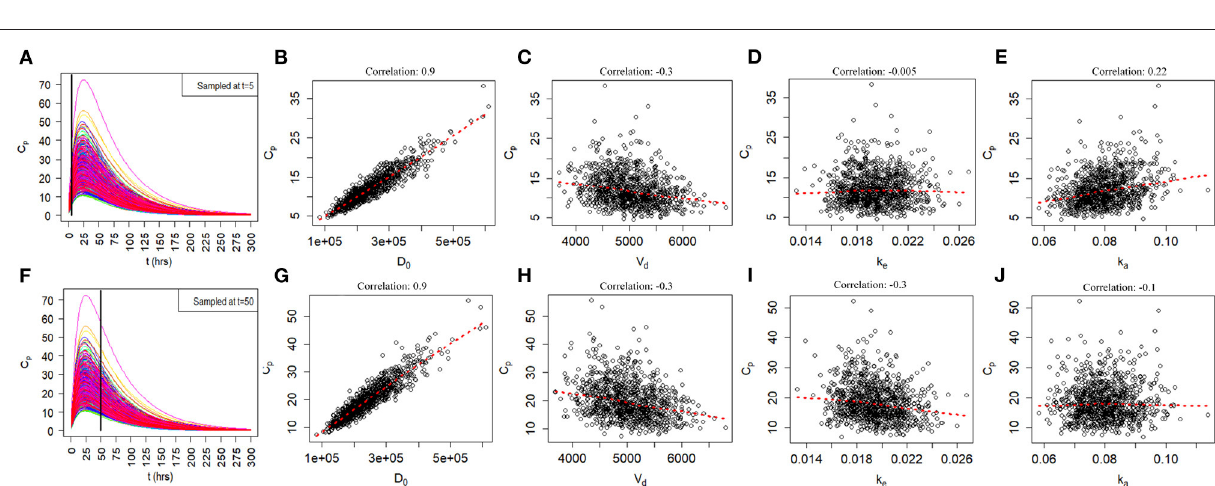
FIGURE 6 | Monte Carlo simulations to investigate relationship of joint uncertainty in D 0 , V d , k e , and k a on model output for the GFAP model. One thousand runs are shown. (A–E) Scatter plots of model output by input and parameter at 5 h. (F–J) Scatter plots of model output by input and parameter at 50 h. Model output (Cp) correlates positively with biomarker release D 0 and negatively with V d . Uncertainty in estimates of k a and k e have a smaller influences on model output. The positive correlation of k a with C p is most apparent at 5 h and the negative correlation of k e with C p is most apparent at 50